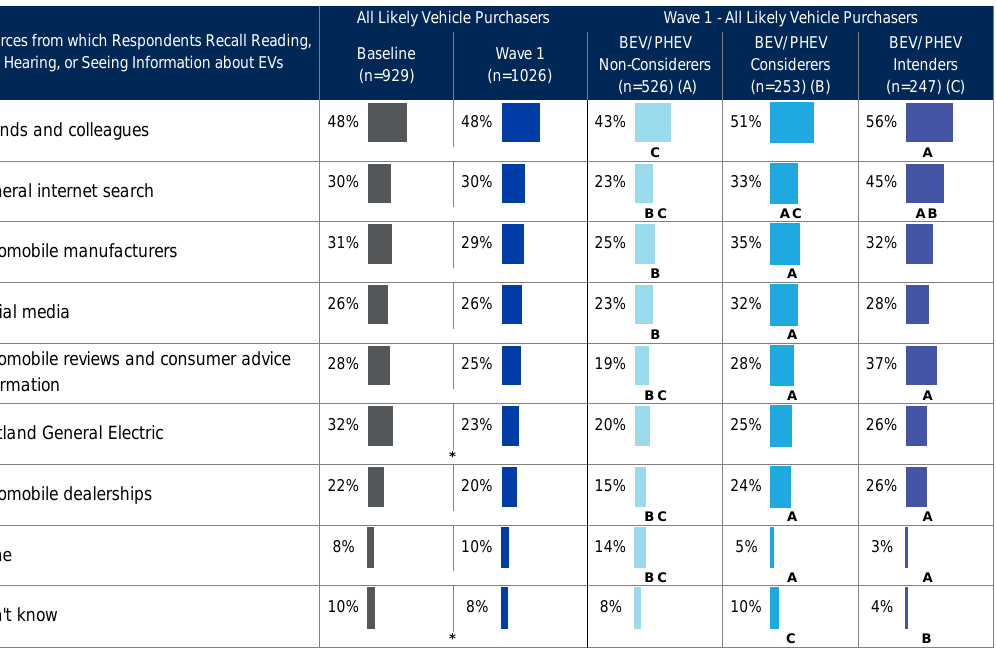
Figure 8. Sources of information respondents recalled reading, hearing, or seeing information about EVs, by survey wave and segment (multiple responses allowed). Note: Letters A—C indicate statistically significant differences between likely vehicle purchaser segments (z-test for proportions, p < 0.05). * Indicates a statistically significant difference between Baseline and Wave 1 survey’s all likely vehicle purchasers (z-test for proportions, p <